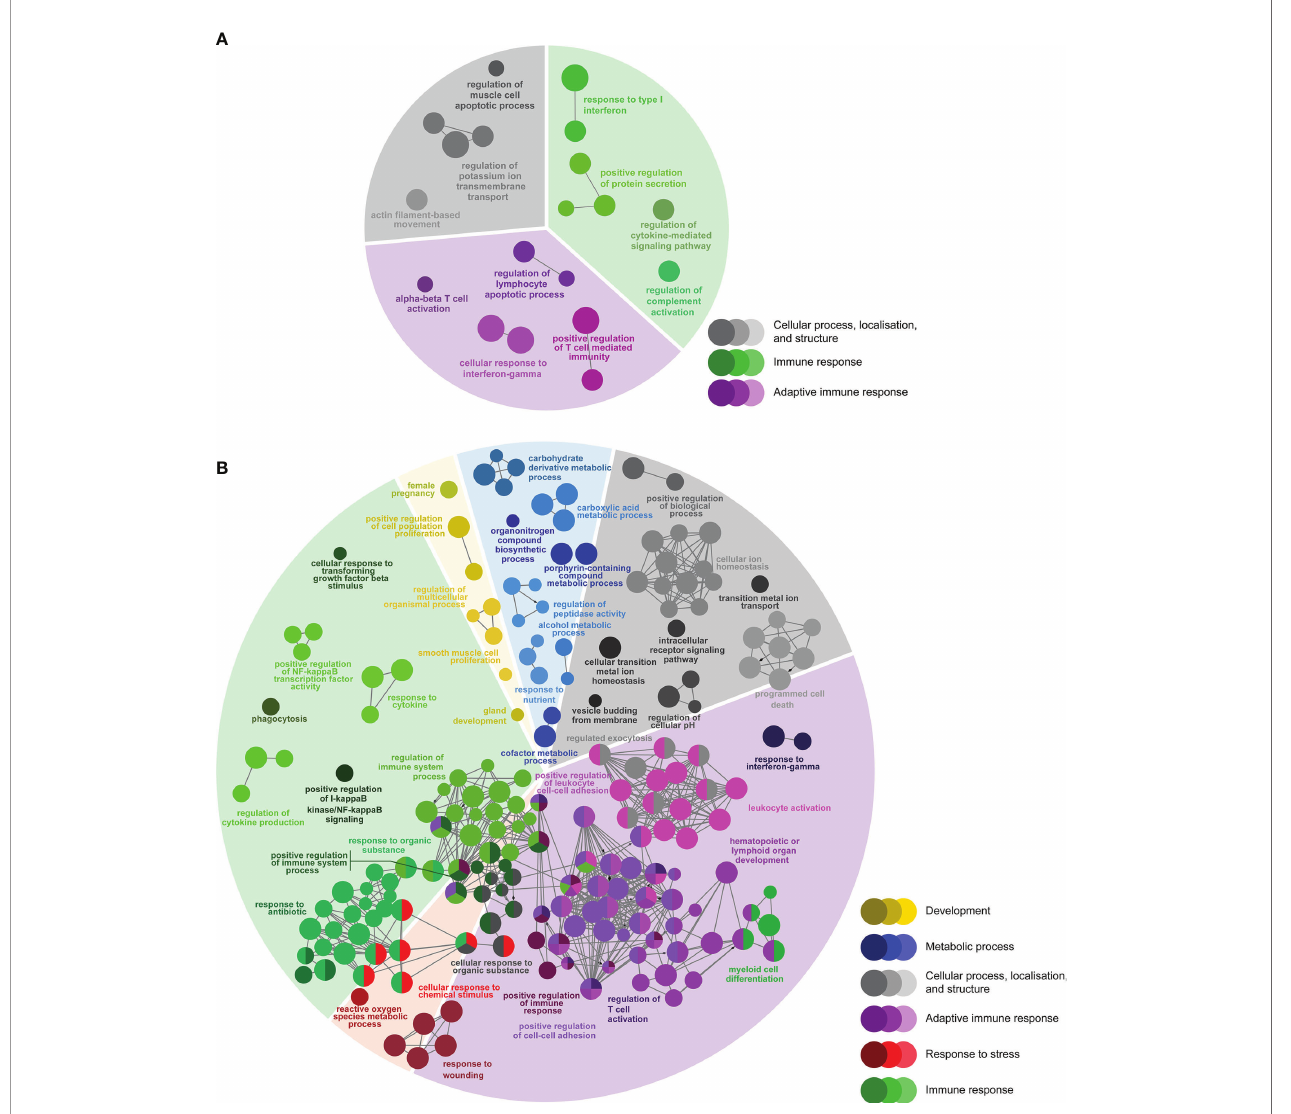
FIGURE 5 | Enriched biological processes GO term networks of (A) SRS-responsive probes only identi fi ed in L-SRS group (n = 166) and (B) SRS-responsive probes only identi fi ed in H-SRS group (n = 1606) in the head kidney of Atlantic salmon at 21 days post-injection (DPI). Nodes represent signi fi cantly enriched GO terms [right-sided hypergeometric test, p-values corrected by Benjamini-Hochberg of 0.01 (i.e. FDR = 1%)]. GO terms are grouped by functional theme and arranged to fi t the sectors of a pie chart representing the proportion of GO terms in each functional theme. Nodes are colored according to the functional theme to which they were assigned. Grey lines in between GO terms indicate high connectivity (kappa coef fi cient > 0.5). Lines with arrows indicate the direction of positive regulation between GO terms, and lines with diamonds indicate the direction of regulation between GO